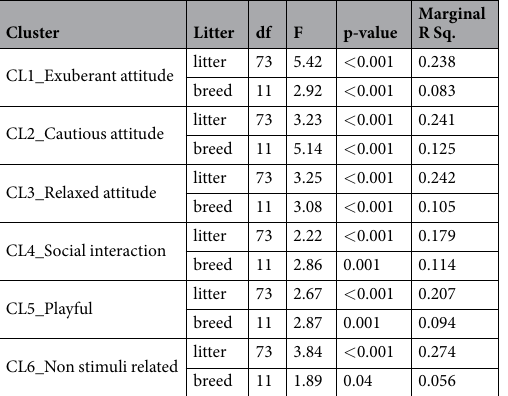
Table 1. GLMM to determine the effect of litter and breed on each cluster group. Only significant factors are shown here, marginal R squared represents the explained variance of each fixed